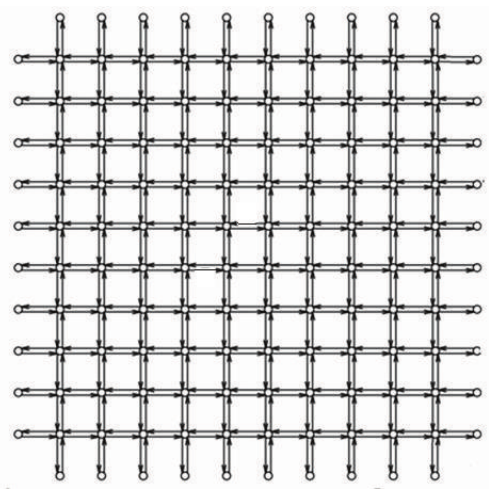
Figure 1: 10 × 10 bidirectional grid network.